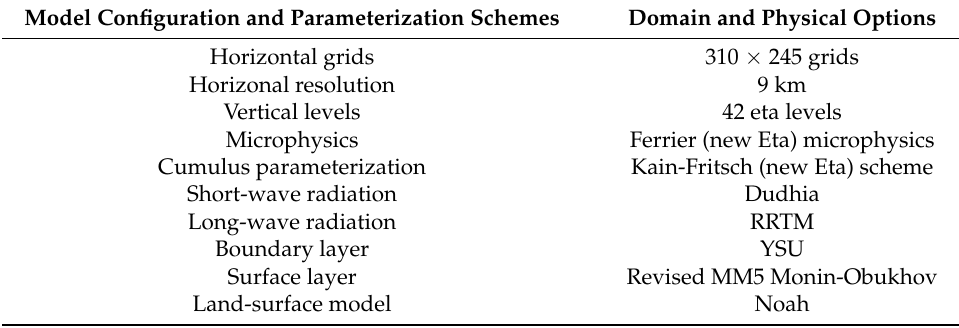
Table 1. Model configuration and physical options of WRF model simulation.